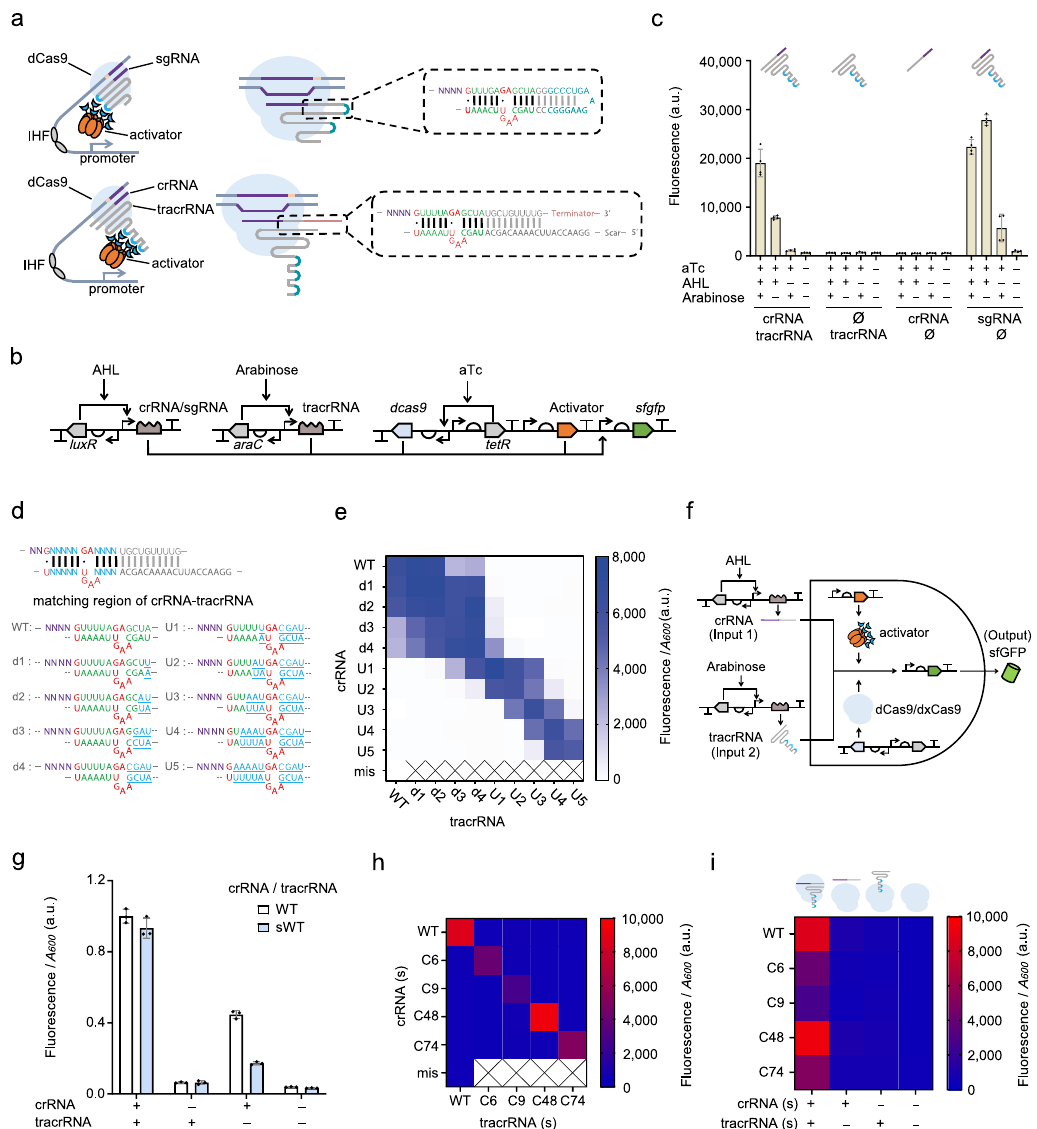
Fig. 1 Dual-RNA mediated CRISPRa system reveals the programmability of crRNA-tracrRNA hybridization. a Schematics showing the original sgRNA mediated eukaryote-like CRISPRa system (top) and the dual-RNA mediated CRISPRa system (bottom). Green base pairs, the minimum structure required for CRISPR/Cas9 function; blue bases, RNA aptamer BoxB; red bases, the bulge structure and wobble base pairs (marked as black dots). b Circuit design of the crRNA-tracrRNA mediated CRISPRa system. The activator PspF Δ HTH:: λ N22plus is driven by constitutive promoter J23106 38 . The anhydrotetracycline (aTc), N-(3-oxohexanoyl)-L-homoserine lactone (AHL), and arabinose are the inducers for promoters P tet , P lux2 , P BAD , respectively. c Test of the combination of three components in the crRNA-tracrRNA mediated CRISPRa, and comparison of the function of gRNAs before and after being split. Induction combinations were achieved via presence ( + ) or absence ( − ) of inducers. Error bars, mean values + / − s.d. ( n = 4). d Design of the library for testing reprogrammed crRNA-tracrRNA hybridized pairs. The blue letter ‘ N ’ indicates the substituted base pairs. The representation of motifs in the remaining sequences on the bottom is the same as those in a . e Orthogonality test of reprogrammed crRNA-tracrRNA pairs. The label ‘ mis ’ indicates the WT crRNA has a mismatched spacer (LEB3) with the target UAS (LEA2). The reprogrammed tracrRNAs and crRNAs were combined in pairs. ( n = 3). f Design of orthogonal AND gates based on reprogrammed crRNA-tracrRNA paring. g The AND gate function based on the original tracrRNA design and the truncated tracrRNA. Normalization was performed with the output of WT tracrRNA-based device at ‘ On ’ state. Error bars, mean values + / − s.d. ( n = 3). h The heat map shows the outcome of an orthogonality test of the WT and 4 randomly generated crRNA-tracrRNA paired sequences. The ‘ (s) ’ indicates that the short 14 bp version of crRNA-tracrRNA pairs was used in this test. ( n = 3). i Each orthogonal crRNA-tracrRNA mediated CRISPRa device displays the Boolean AND logic pro fi le. The cartoon above shows the presence or absence of the components of the CRISPR complex under different induction conditions. The data in the active state and induction conditions are the same as in h . ( n = 3). a.u., arbitrary units. Source data are provided as a Source Data fi